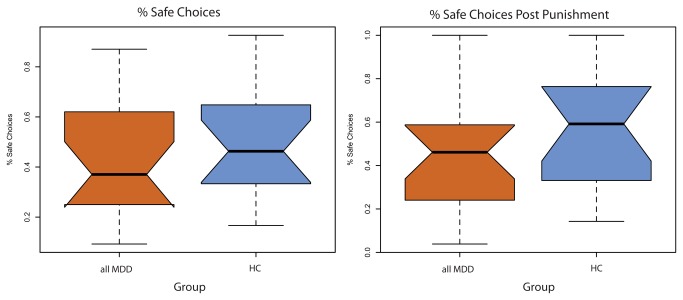
Group differences in choice frequencies during risky decision-making.HC: Healthy controls; MDD: Major depressive disorder.Notched box plots illustrate choice frequencies as a function of group (all MDD and HC). Notches reflect confidence intervals around the median (median +/- (1.57 x IQR/√n), and, in case of no overlap, indicate significant differences between medians. No differences between all MDD and HC were observed for median choice frequencies over the safe option (20 points) overall, as well as immediately following a punished trial.